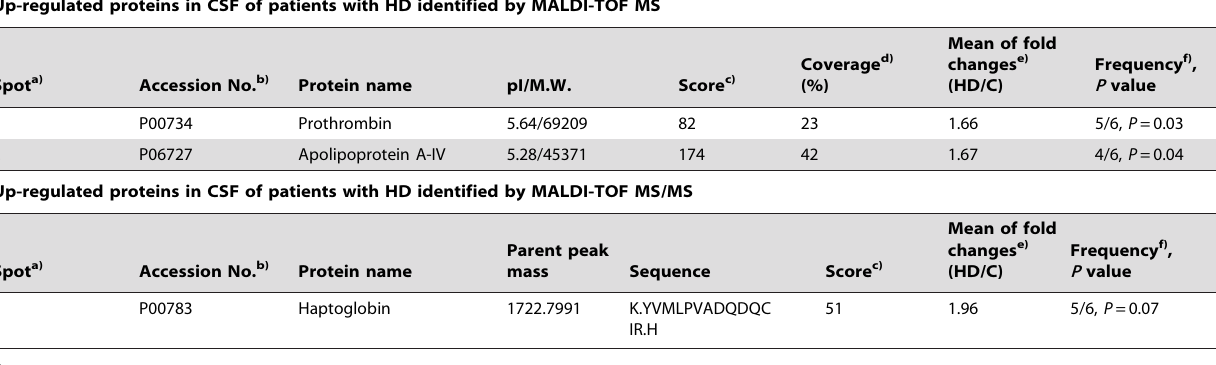
Table 2. Differentially-expressed protein molecules in CSF of Huntington’s disease (HD) patients.